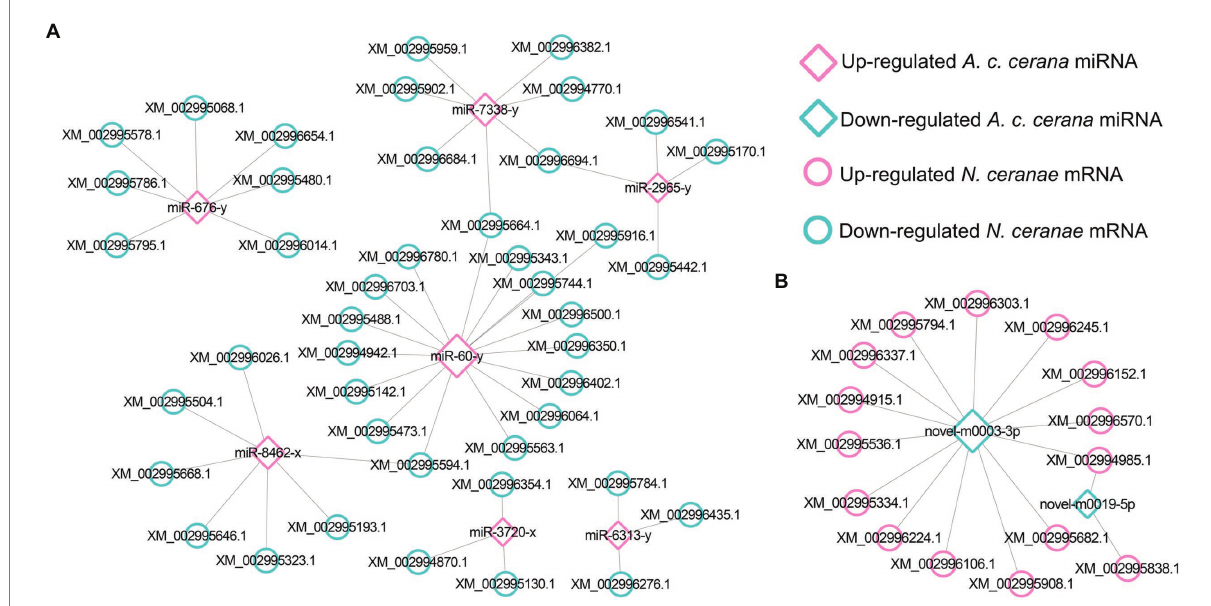
FIGURE 2 Regulatory network between A. c. cerana DEmiRNAs and target DEmRNAs in N. ceranae at 10 dpi. (A) Regulatory network between up-regulated miRNAs in host and down-regulated mRNAs in microsporidian. (B) Regulatory network between down-regulated miRNAs in host and up- regulated mRNAs in microsporidian.